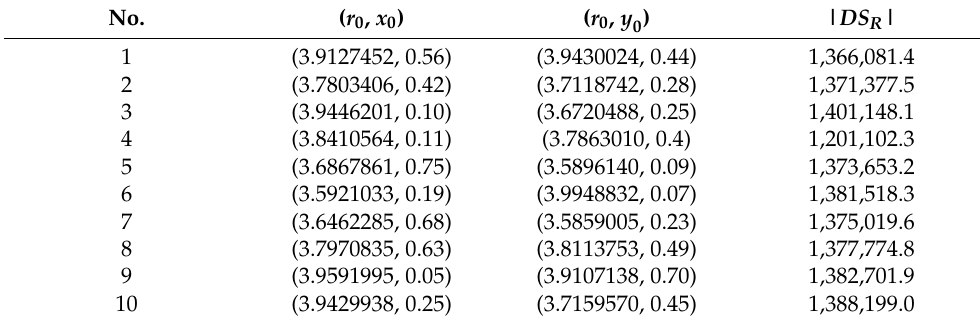
Table 4. Comparisons of the relative configurational entropy of confused DEM B under different keys in the first round. No.